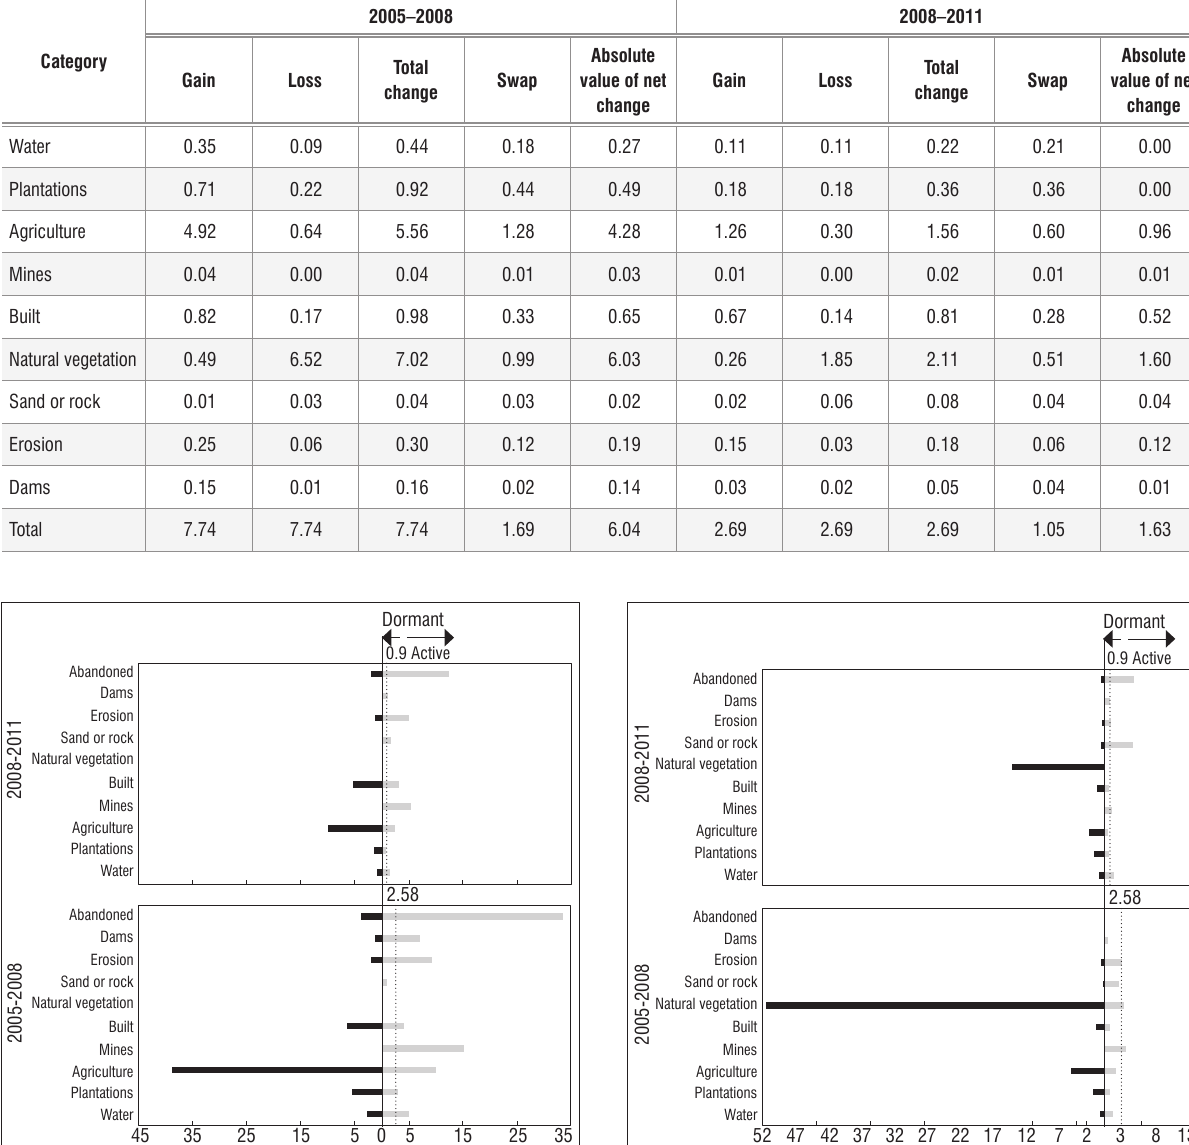
Table 4: Percentage change in the aggregated land-cover categories in the KwaZulu-Natal landscape for 2005–2008 and 2008–2011. The gain in semi-natural vegetation (the change of non-natural vegetation classes back into a semi-natural state at a future time point) was tracked by the ‘abandoned’ category in the Intensity Analysis. 2005–2008 2008–2011 Absolute Absolute Category Total Total Gain Loss Swap value of net Gain Loss Swap value of net change change change change